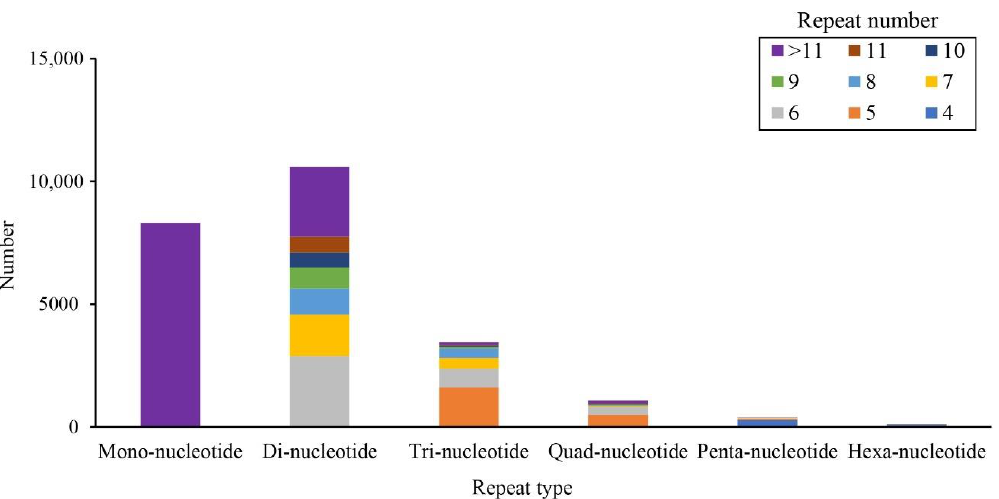
Figure 6. The distribution of different